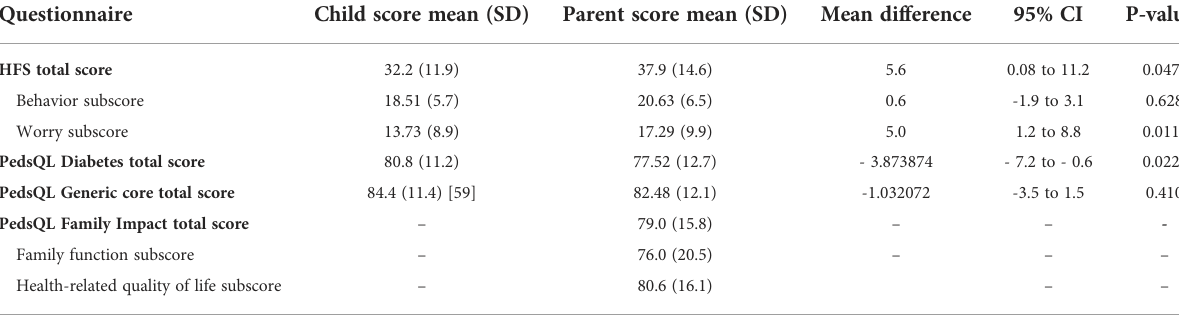
TABLE 2 Questionnaire scores of children and adolescents and their